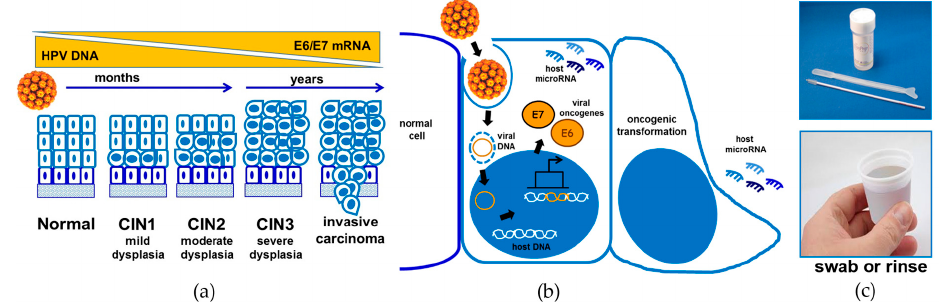
Figure 1. ( a ) Timeline of cervical cancer progression. Human papillomavirus (HPV) infects the basal cells of the cervical epithelium (dark blue) exposed by wounding, leading to cytological abnormalities; ( b ) Expression of viral oncogenes E6/E7 accompanies malignant transformation; ( b ) HPV infection pathway. Following viral entry, viral replication is synchronous with host cellular DNA replication. Integrated and episomal viral DNA produce E6 and E7 oncoproteins. E6 targets p53 for